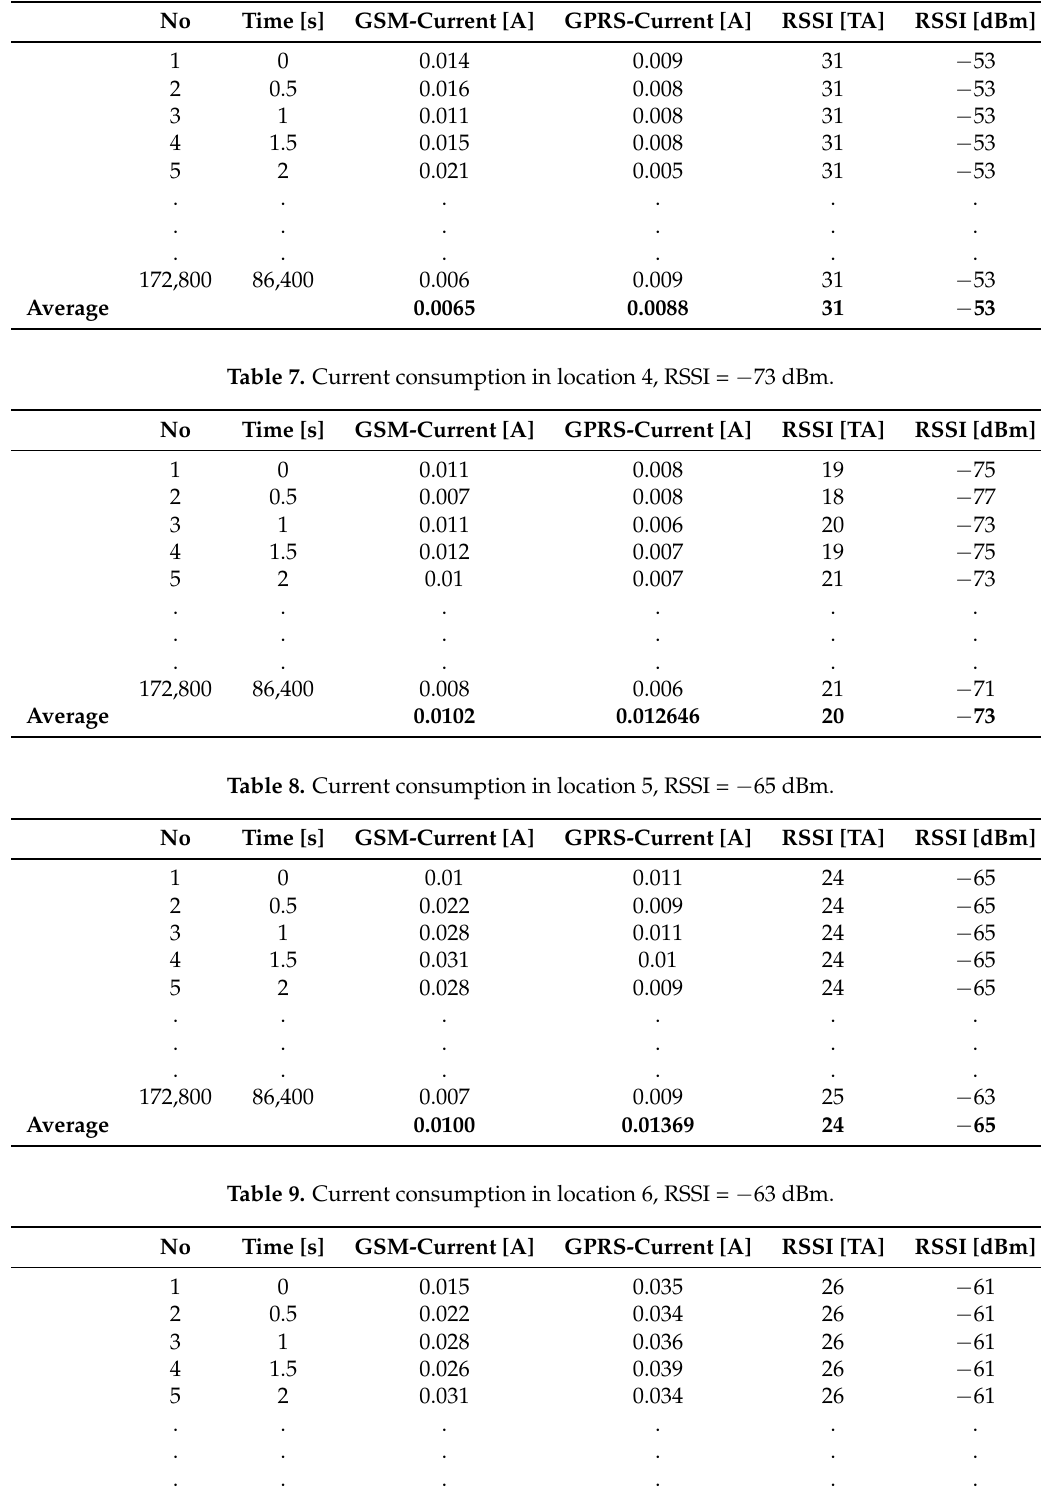
Table 6. Current consumption in location 3, RSSI = − 53 dBm.